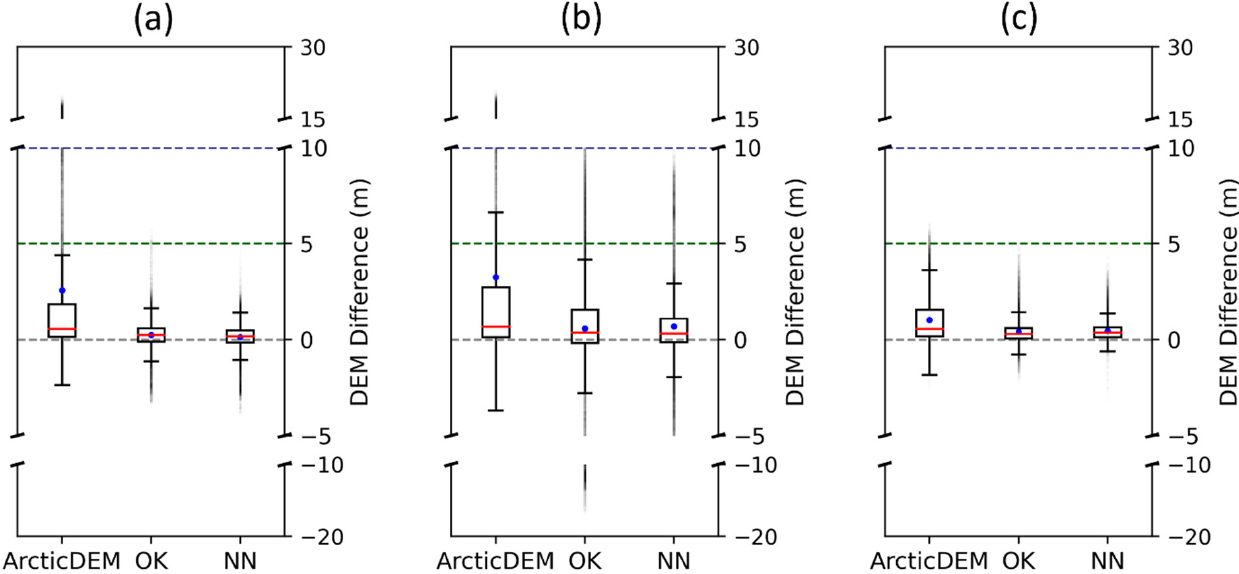
predicted DTMs and the reference lidar-derived DTMs.